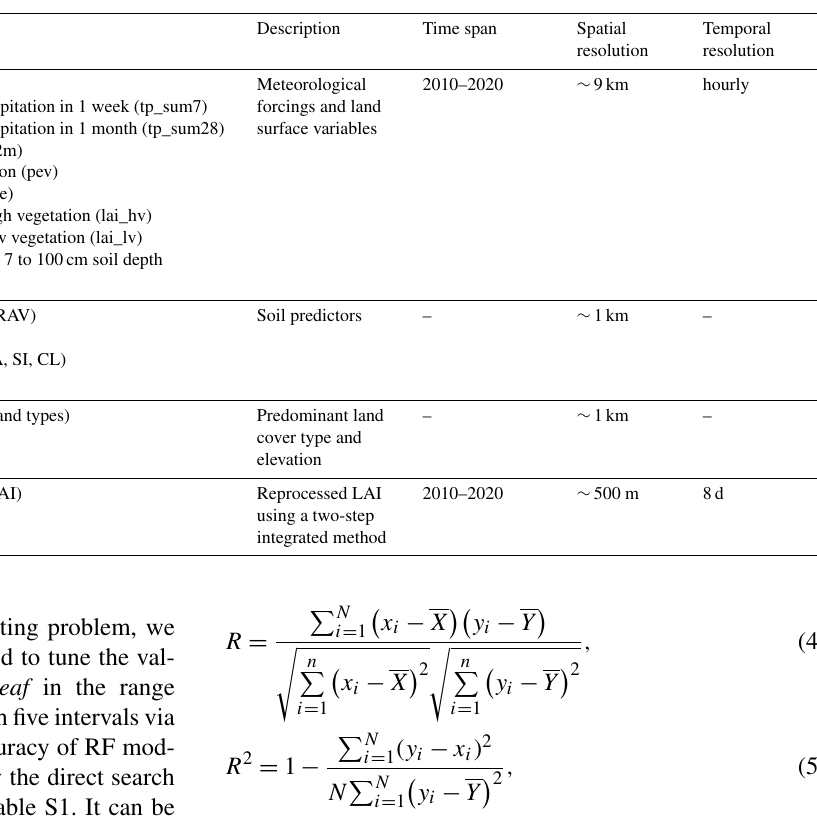
Table 1. Details of the predictors for training the random forest